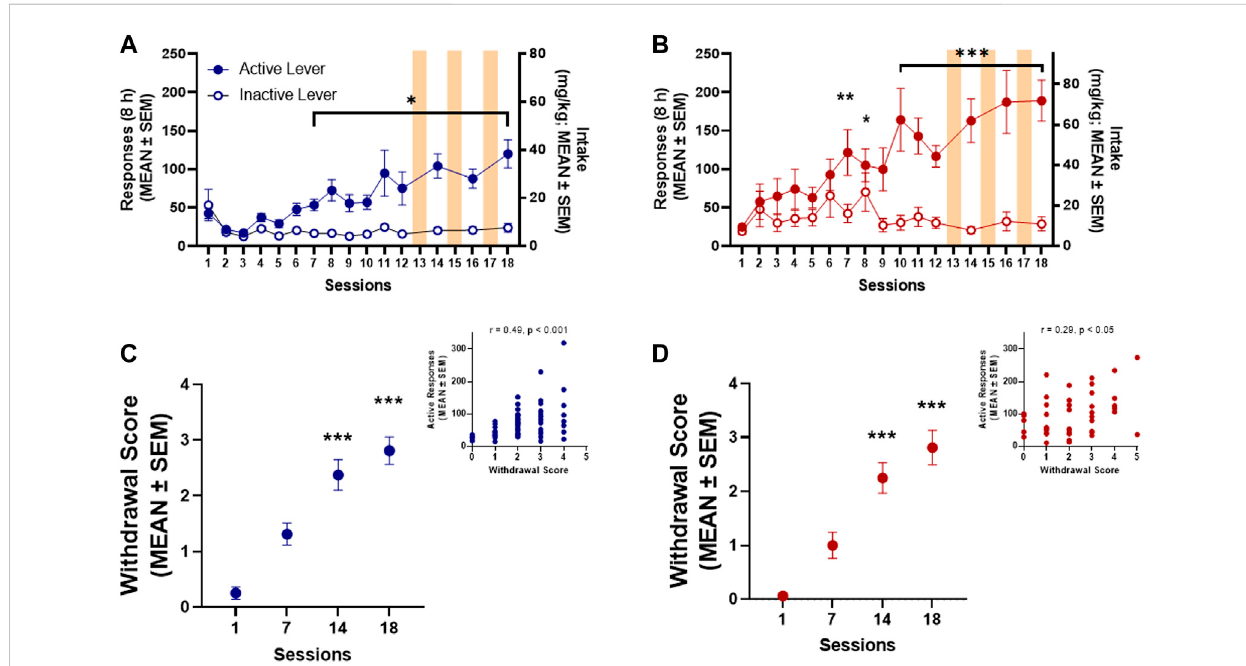
FIGURE 2 Oxycodoneself-administrationinmales( n =15) (A) andfemales( n =14) (B) .* p < 0.05,** p < 0.01,*** p < 0.001,vs.inactivelever(Dunnett ’ smultiple- comparison post hoc test). Somatic withdrawal in both males (C) and females (D) . ***p < 0.001, vs. session 1 (Dunn ’ s multiple-comparison post hoc test). Insets: Correlation plot between somatic withdrawal score and number of oxycodone infusions.